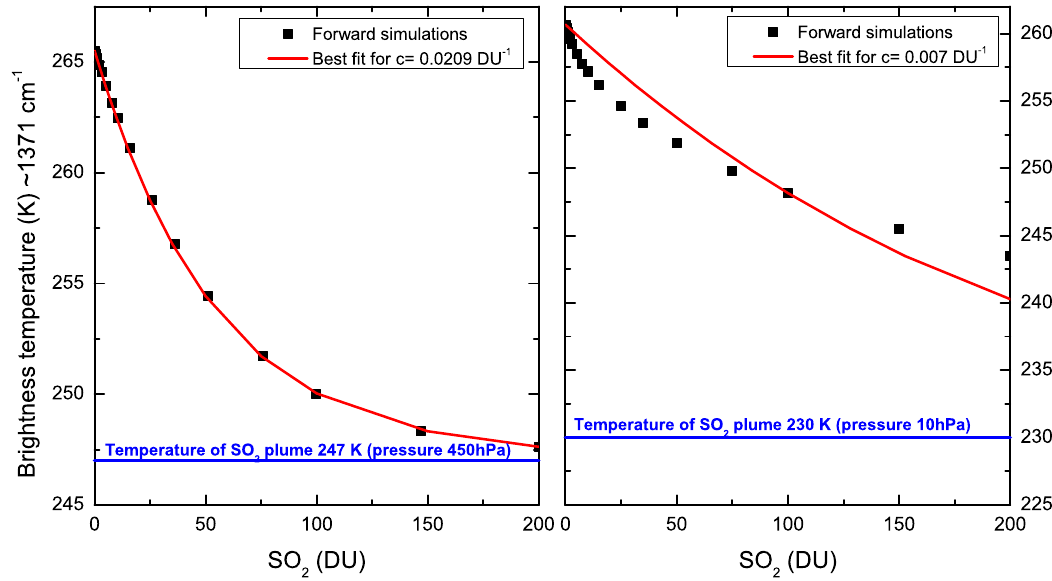
Fig. 2. Brightness temperature at 1371.75cm − 1 as a function of SO 2 mass loading for a low (left, plume at 247K and 450hPa ∼ 5km) and high (right, plume at 230K and 10hPa ∼ 25km) altitude plume. The colored black squares were calculated from simulated IASI spectra, while the red full line is a best fit of these simulations with Eq.